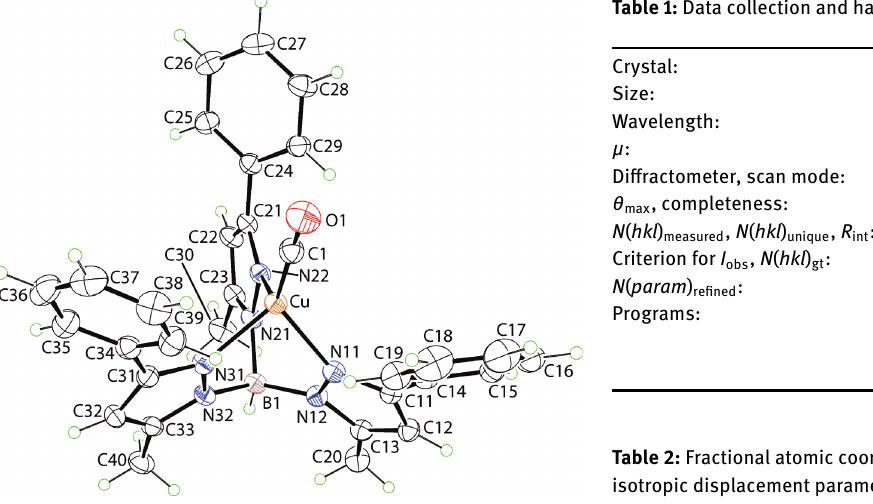
Table 1: Data collection and handling.